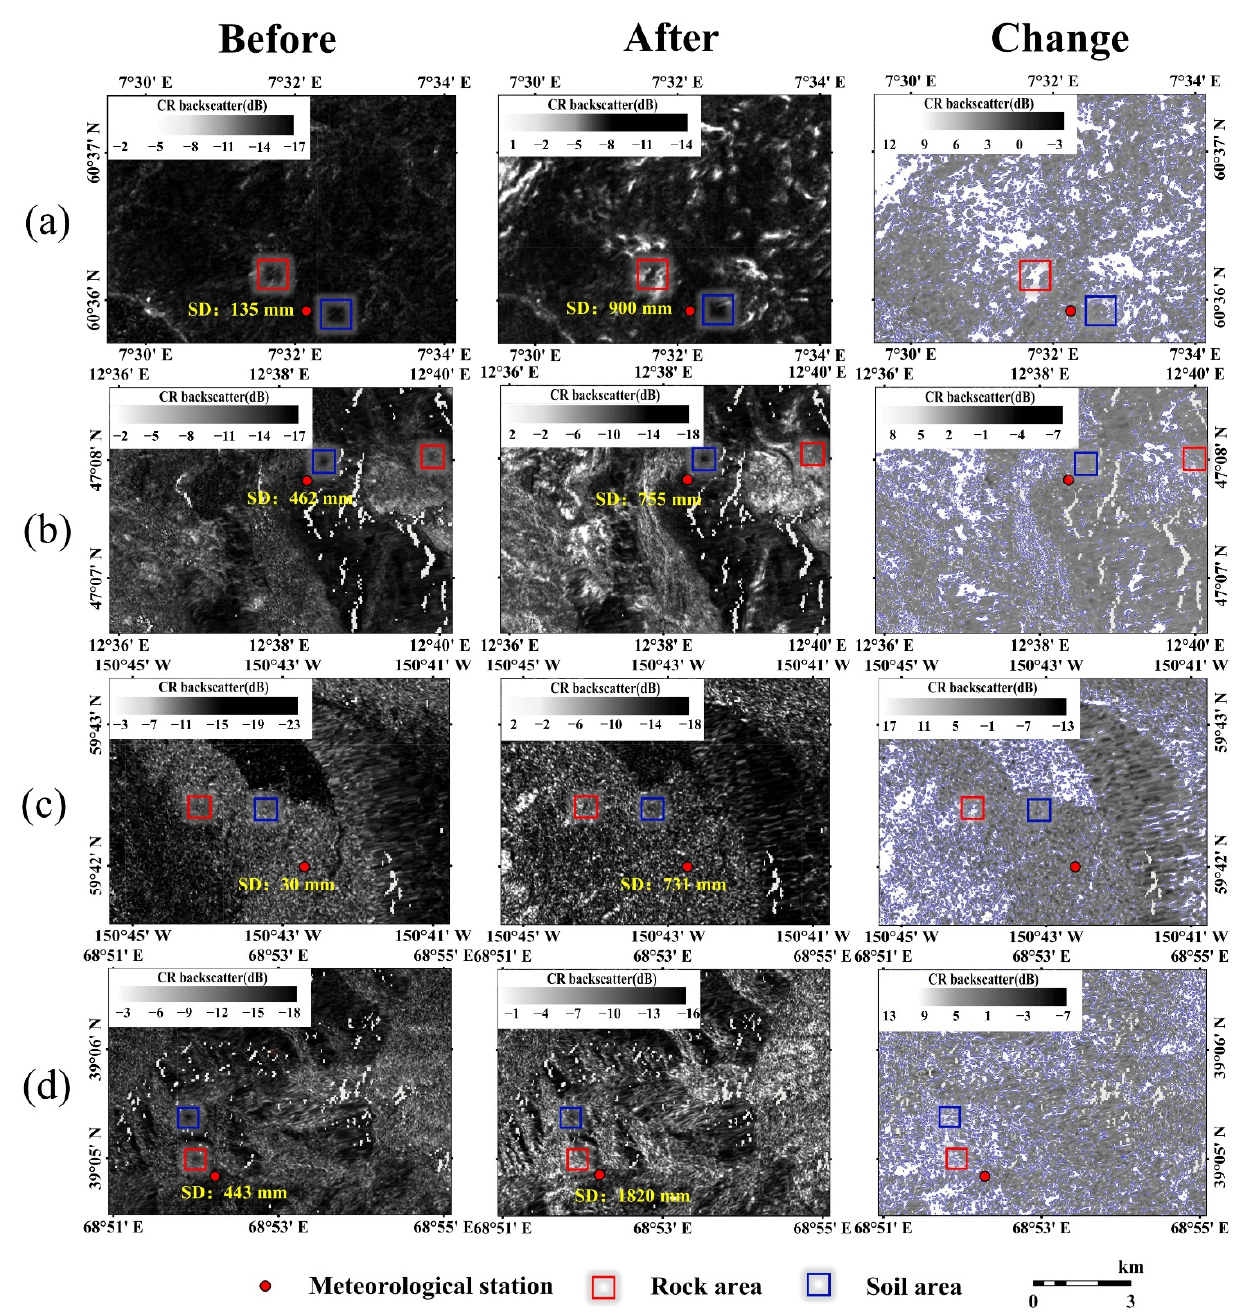
Figure 8. The CR-band images before and after the peak snow accumulation month and the difference map obtained by the change-detection method The left and middle columns show the monthly mean CR maps for November 2019 and February 2020, while the right column shows the CR variation caused by snow accumulation, which was obtained by image processing. The red boxes represent the rock areas, and the blue boxes represent the soil areas covered by sparse vegetation. The red point indicates the location of the meteorological station and next to it is the average SD (marked in yellow). ( a ) FV; ( b ) RS; ( c ) NK; ( d ) AP.